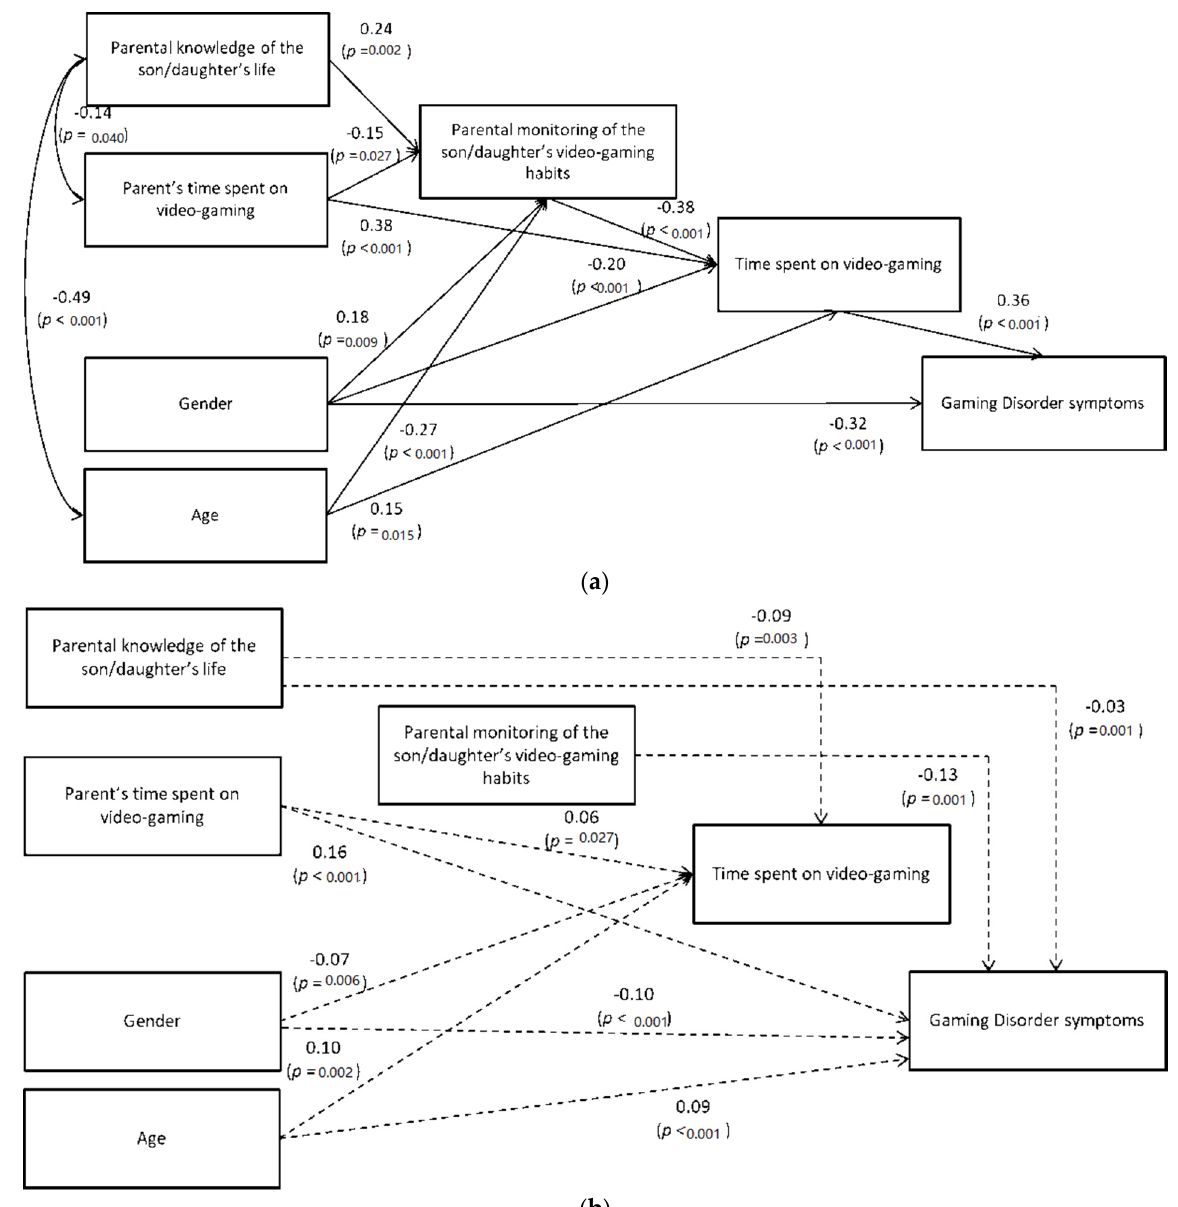
Figure 1. ( a ) Path model with direct effects on the variables controlling for the son/daughter's gender and age. ( b ) Path model with indirect effects on the variables controlling for the son/daughter's gender and age.